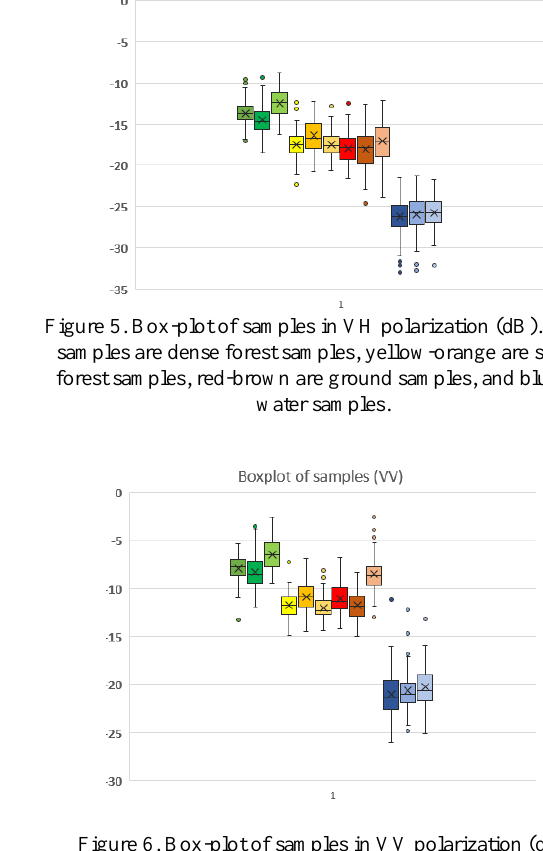
Figure 6. Box-plot of samples in VV polarization (dB) However, the sparse forest and ground samples’ ranges